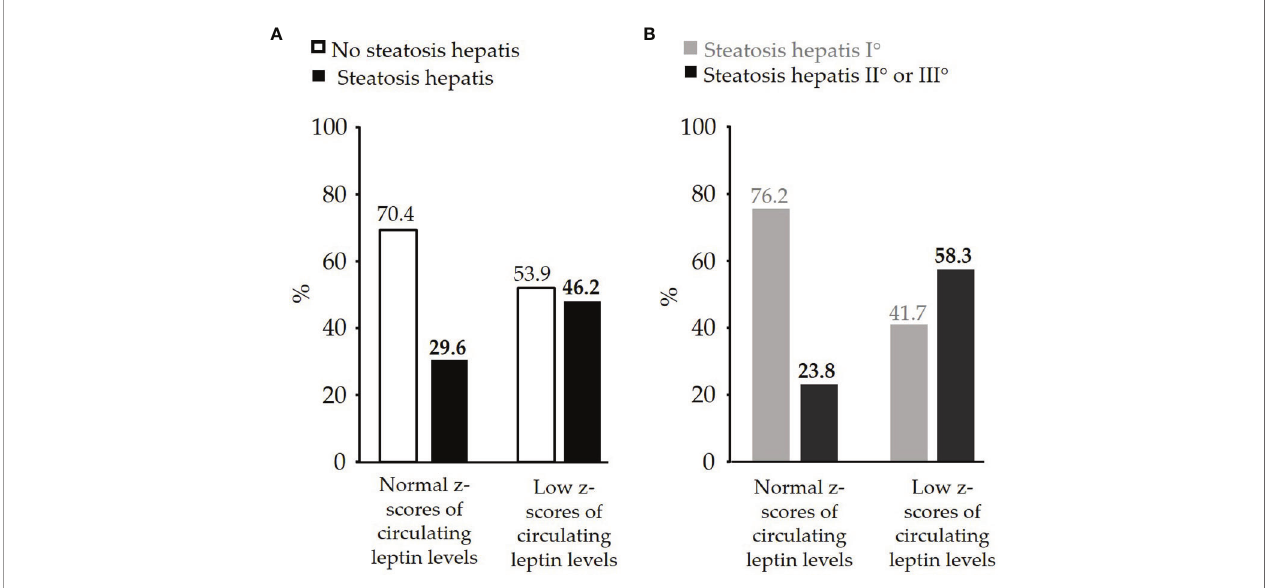
FIGURE 2 | (A) Comparison of percentage of pre-pubertal children with obesity and with or without diagnosed steatosis hepatis between the group of children with normal z-scores of circulating leptin levels (n=71) and the group of children with low z-scores of circulating leptin levels (n=26), (B) Comparison of percentage of pre- pubertal children with obesity and with steatosis hepatis I° (mild: n=21) or steatosis hepatis II° or III° (moderate or severe: n=12) between the group of children with normal z-scores of circulating leptin levels and the group of children with low z-scores of circulating leptin